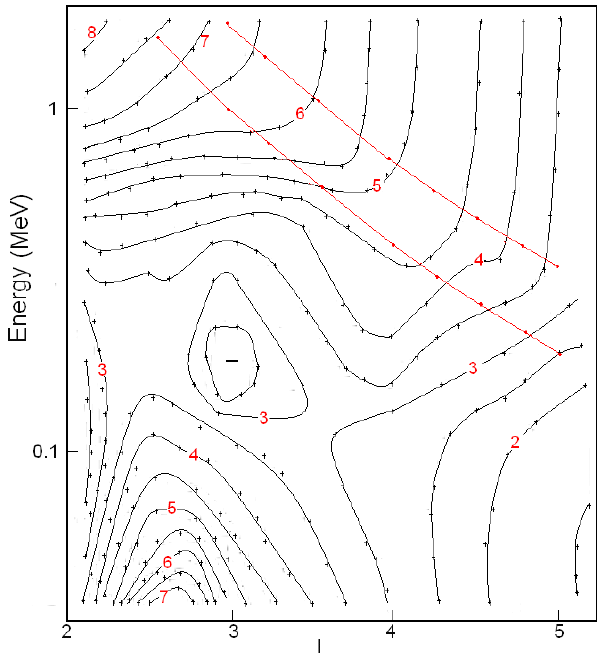
Figure 2. Empirical model of the anisotropy index A(E,L) of the ERB proton fluxes averaged on the data from the satellites obtained near the plane of the geomagnetic equator. Values of A are given on isolines of the anisotropy: A = 1.5–8.5 with the step (cid:49)A = 0 . 5.